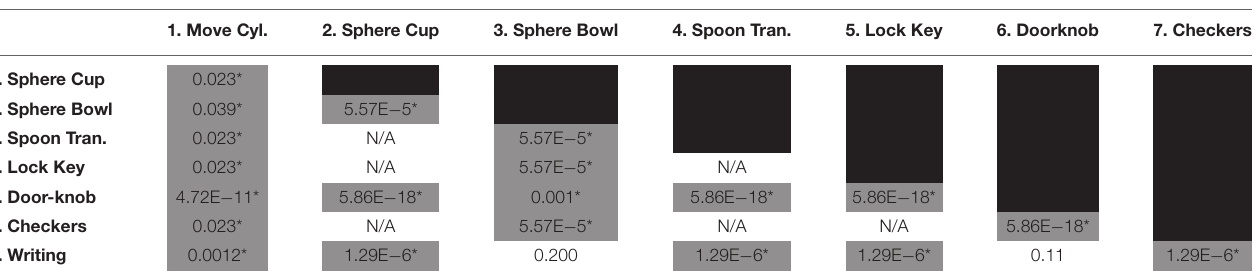
TABLE 6 | Statistical comparison of task completion time for all tasks in